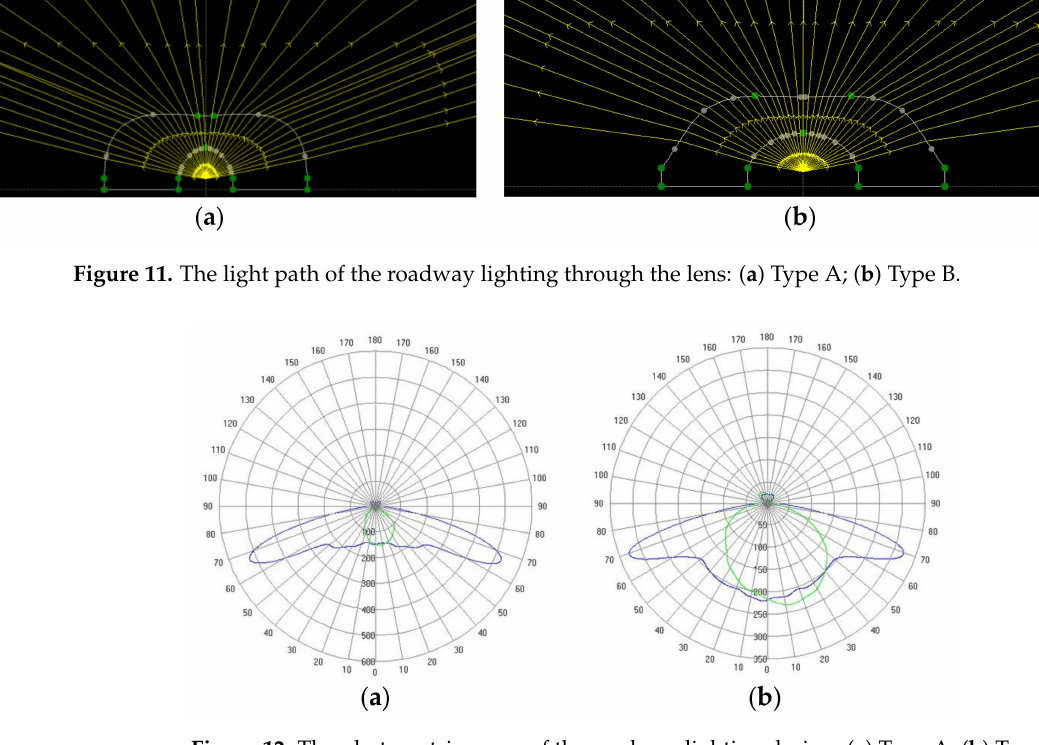
Figure 12. The photometric curve of the roadway lighting design: ( a ) Type A; ( b ) Type B.